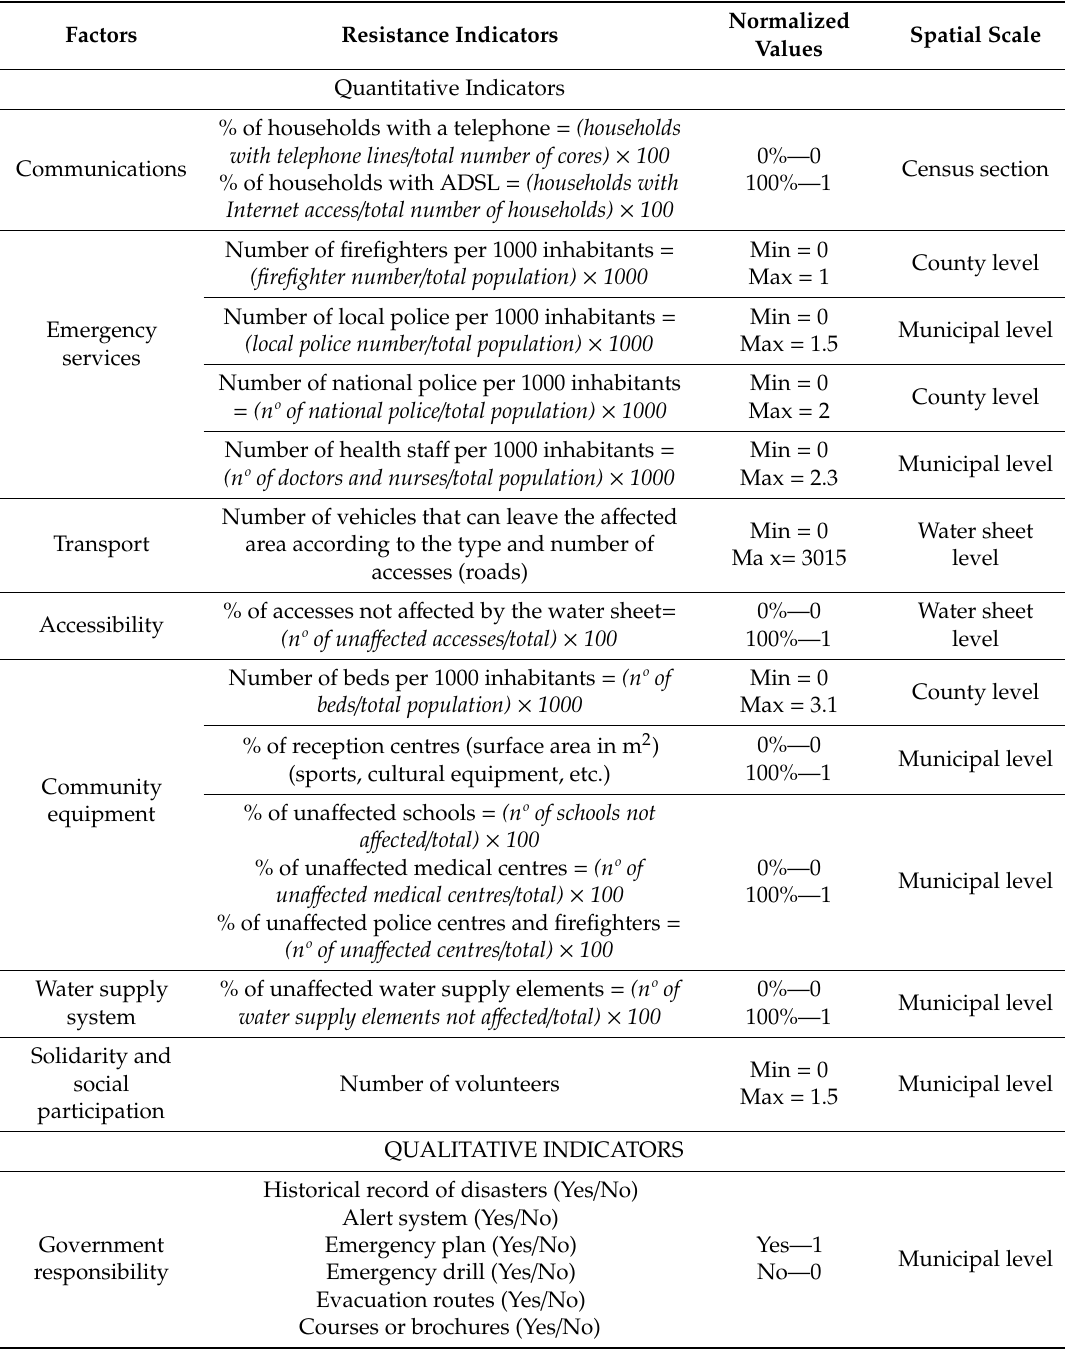
Table 2. Description of the proposed social vulnerability factors and indicators of resistance to flood